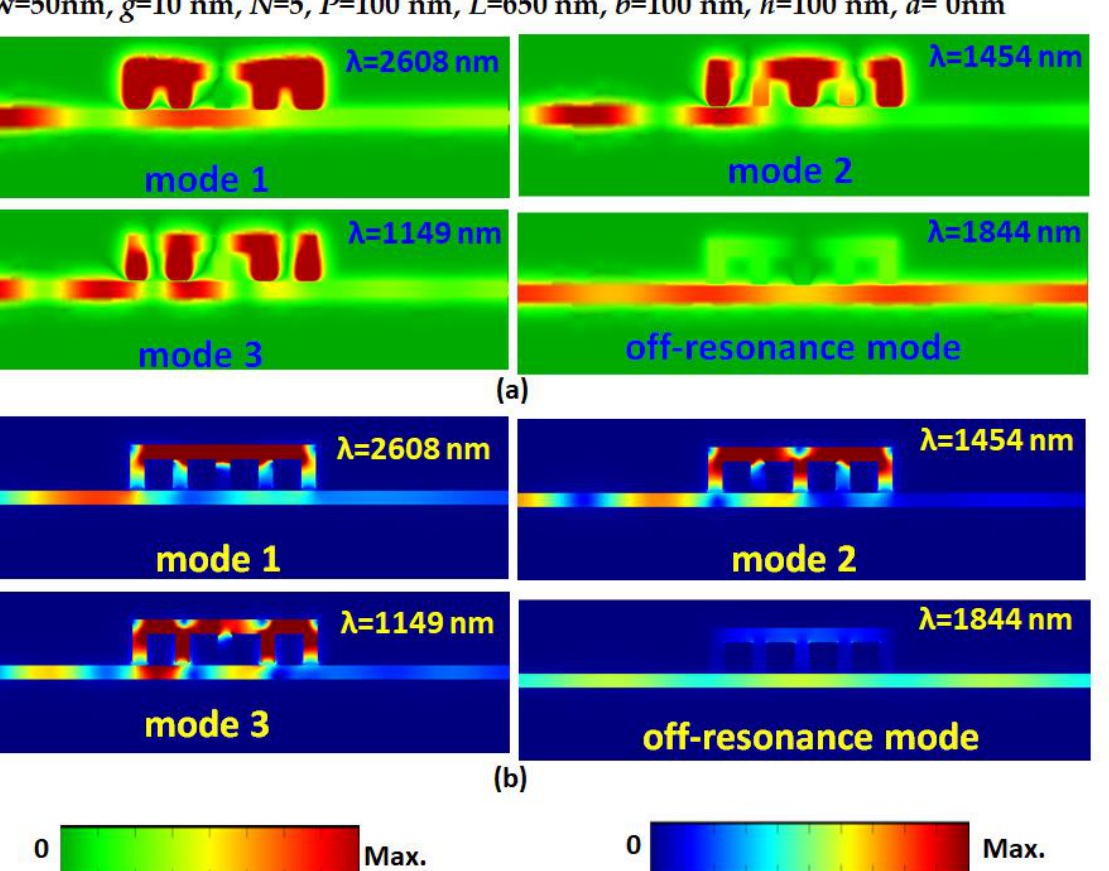
Table 1. Comparison of λ res , FWHM, ΔD, and QF of the designed structures at corresponding reso- nance modes.